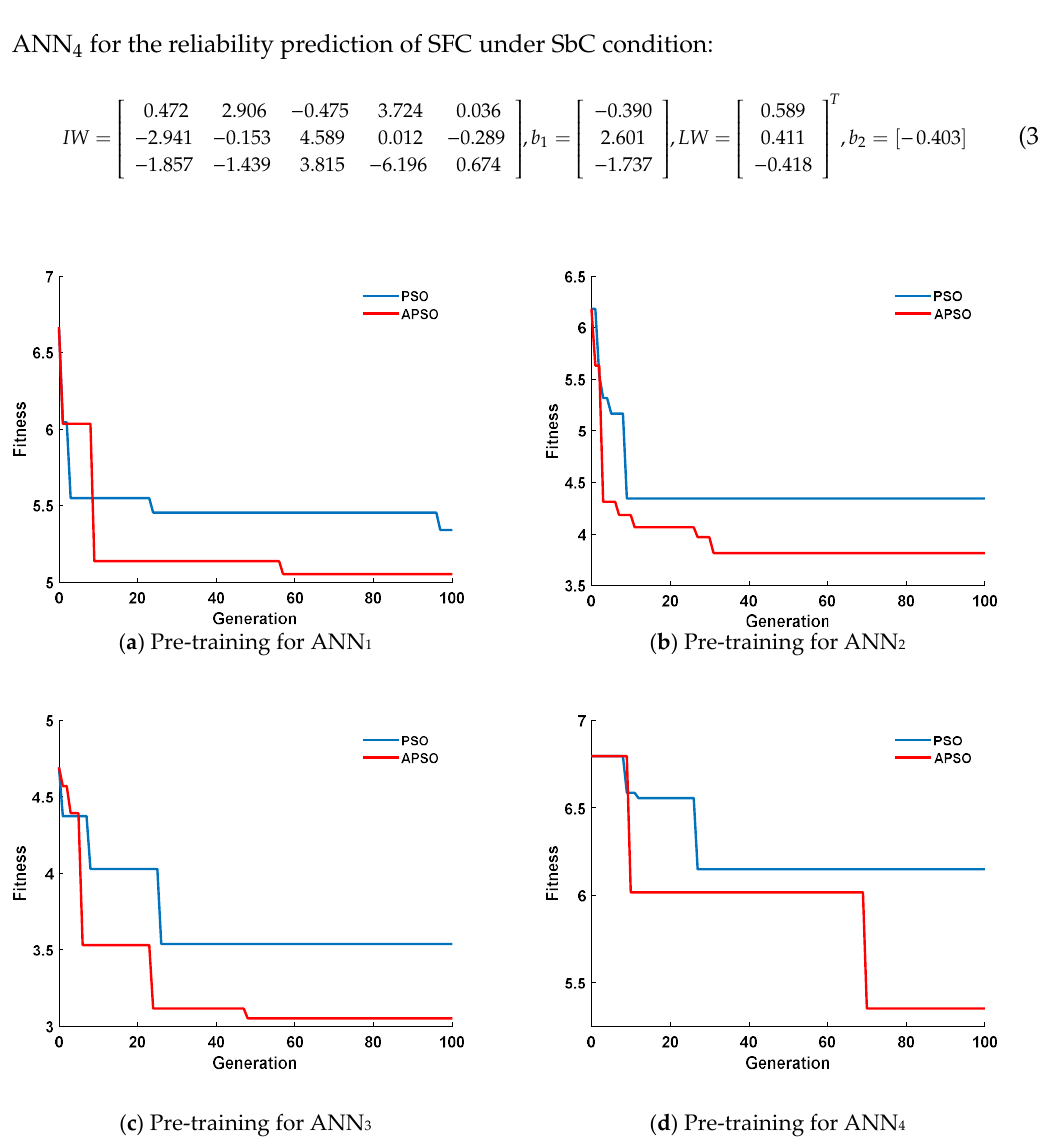
Figure 8. Pre-training convergence performance of the standard Particle Swarm Optimization (PSO) and Adaptive Particle Swarm Optimization (APSO).